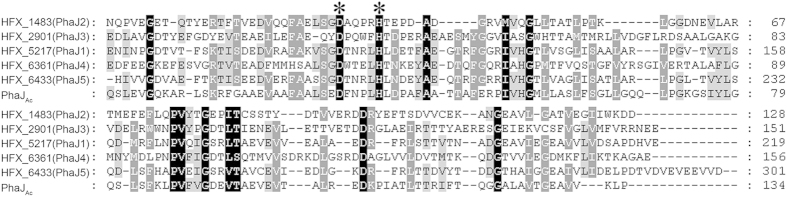
Alignment of the amino acid sequences of (R)-specific enoyl-CoA hydratase (R-ECH) homologous proteins in H. mediterranei.HFX_1483 (GenBank accession number YP_006349178), HFX_2901 (YP_006350558), HFX_5217 (YP_006351037), HFX_6361 (YP_006351469), and HFX_6433 (YP_006351539) are the five putative R-ECHs in H. mediterranei. PhaJAc (BAA21816) is the R-ECH in Aeromonas caviae. The putative active sites are shown with asterisks. The numbers on the right are the positions of the amino acids of the respective proteins. Identical and similar residues are shaded in black and gray, respectively.